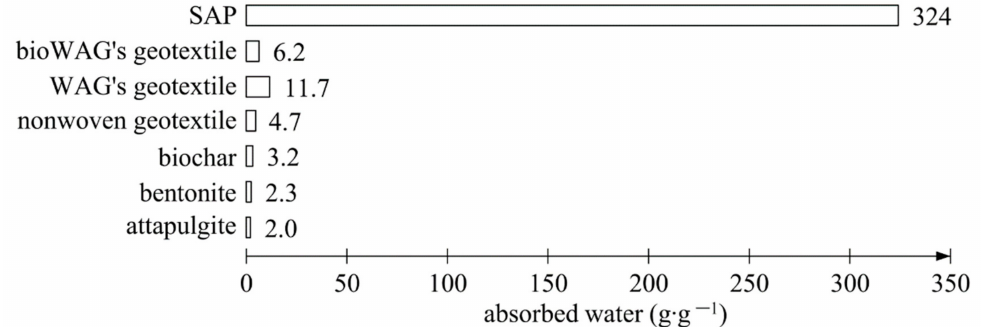
Figure 3. Water absorbency of materials used ( n = 5). The amount of quantity water is presented in conversion as per one gram of soil amendment.